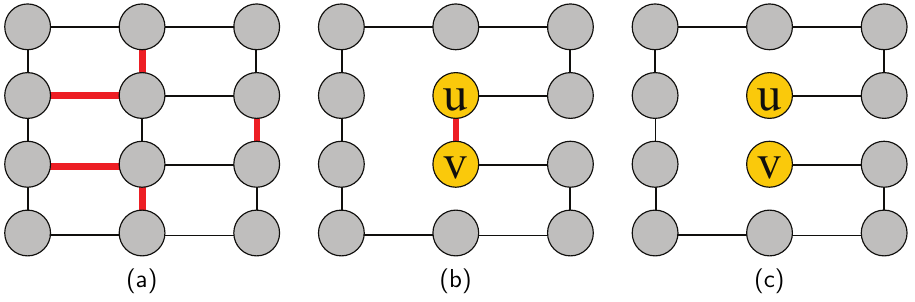
Figure 2. The specific steps of the reduction from the Hamiltonian cycle problem to the LCVMIN and LCRMAX problem: ( a ) original sample network, ( b ) modified network with a Hamiltonian cycle, ( c ) modified network with a Hamiltonian